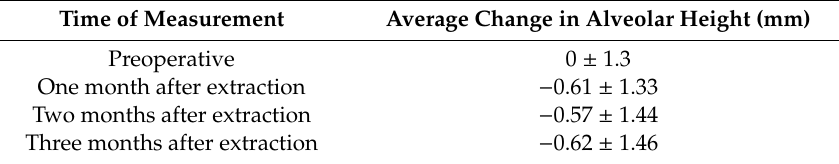
Table 4. Variation in alveolar height variation by time of measurement.